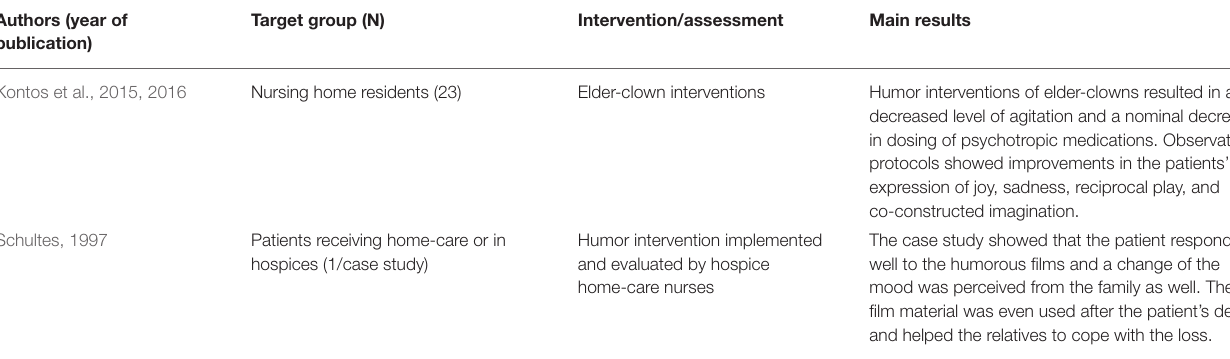
TABLE 1 | Studies including humor interventions.